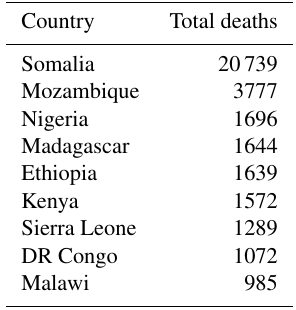
Table 4. Countries most impacted by weather-related disaster deaths in